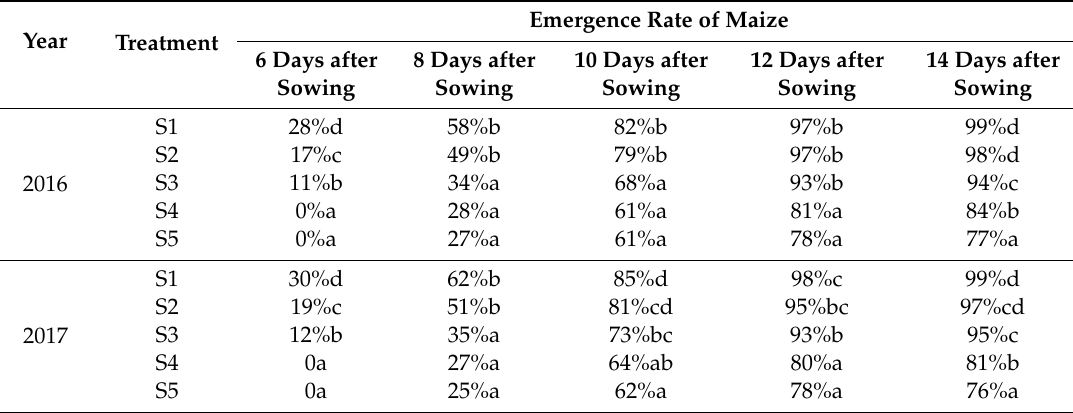
Table 7. Seeding emergence for di ff erent